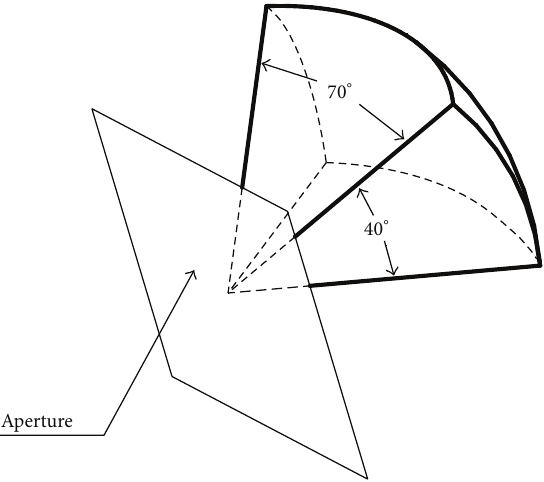
Figure 3: Layout of heliostat field.